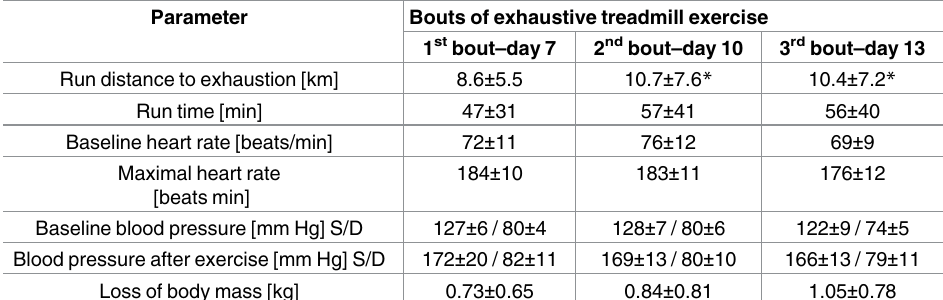
Table 1. Parameters monitored during three repeated exhaustive treadmill exercisebouts separated by three days of resting period.